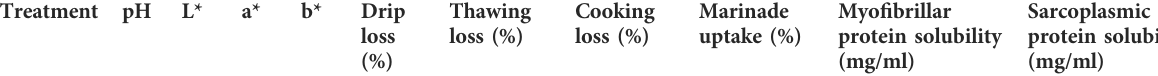
TABLE 4 Quality characteristics and functional properties of breast meat of broilers at slaughter age (day 37). Treatment